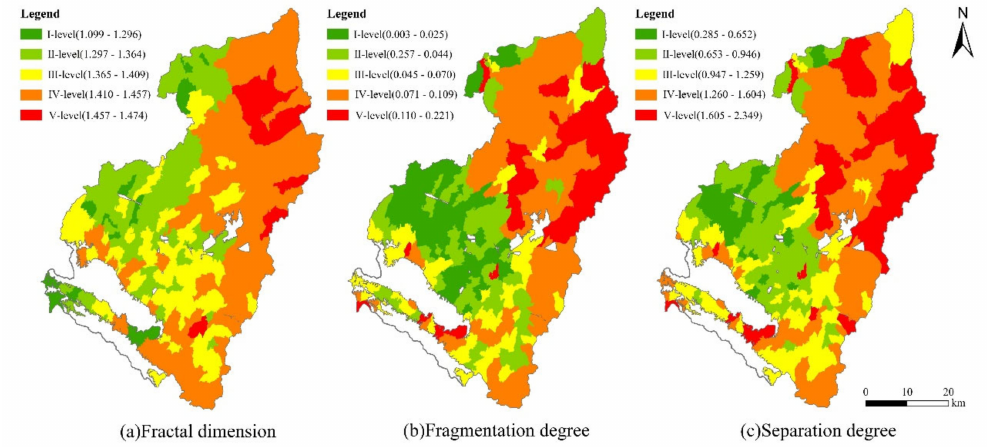
Figure 5. The spatial layout of internal land use in the residential area. ( a ) Fractal dimension, ( b ) Fragmentation degree, ( c ) Separation